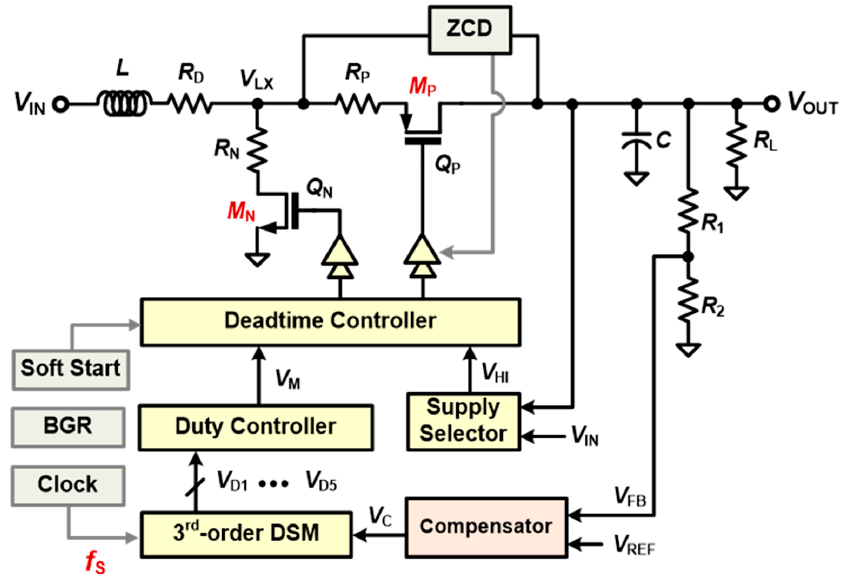
Figure 1. Block diagram of the proposed step-up